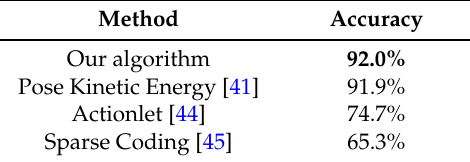
Table 1. Comparison of continuous human action recognition results on CAD-60 dataset.